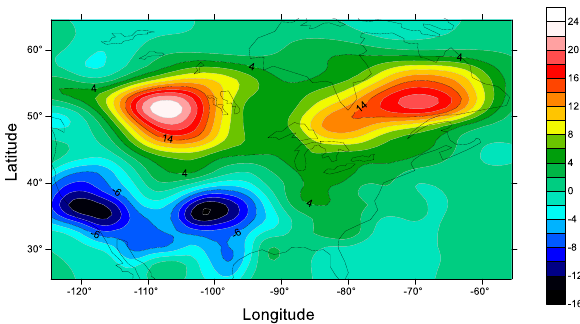
Figure 4. Trend rates of the SWE changes in North America (x10 -3 m /yr.)